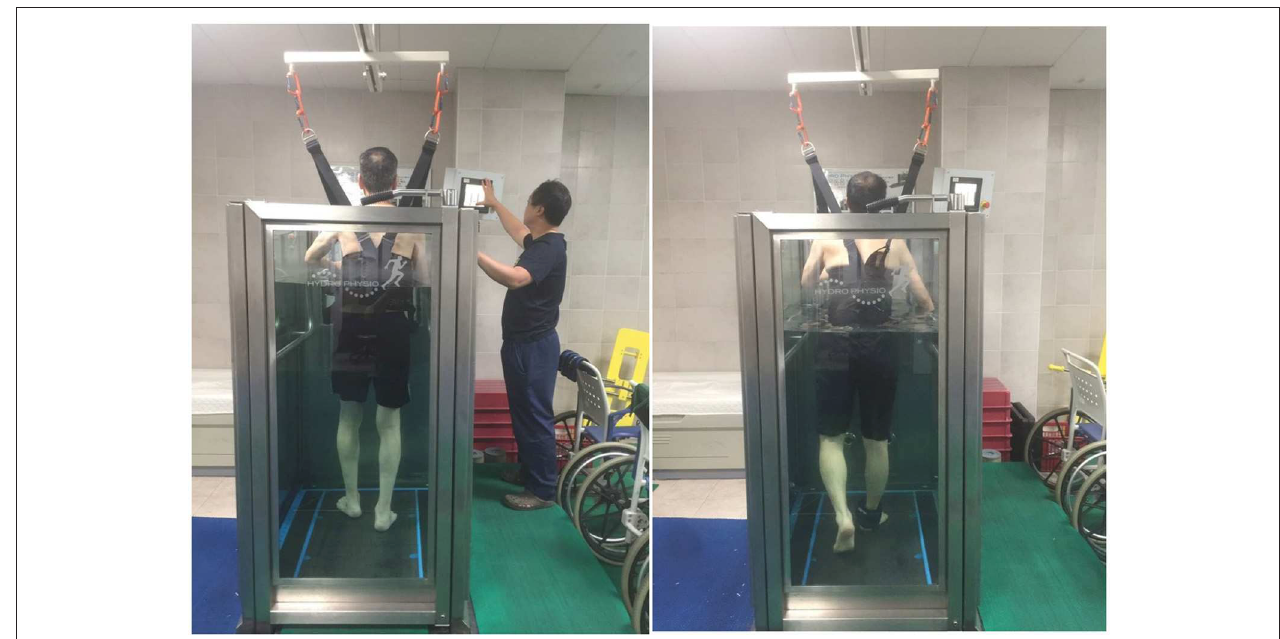
FIGURE 1 | Underwater treadmill training with water-jet resistance (left) and Underwater treadmill training with ankle weight (right)